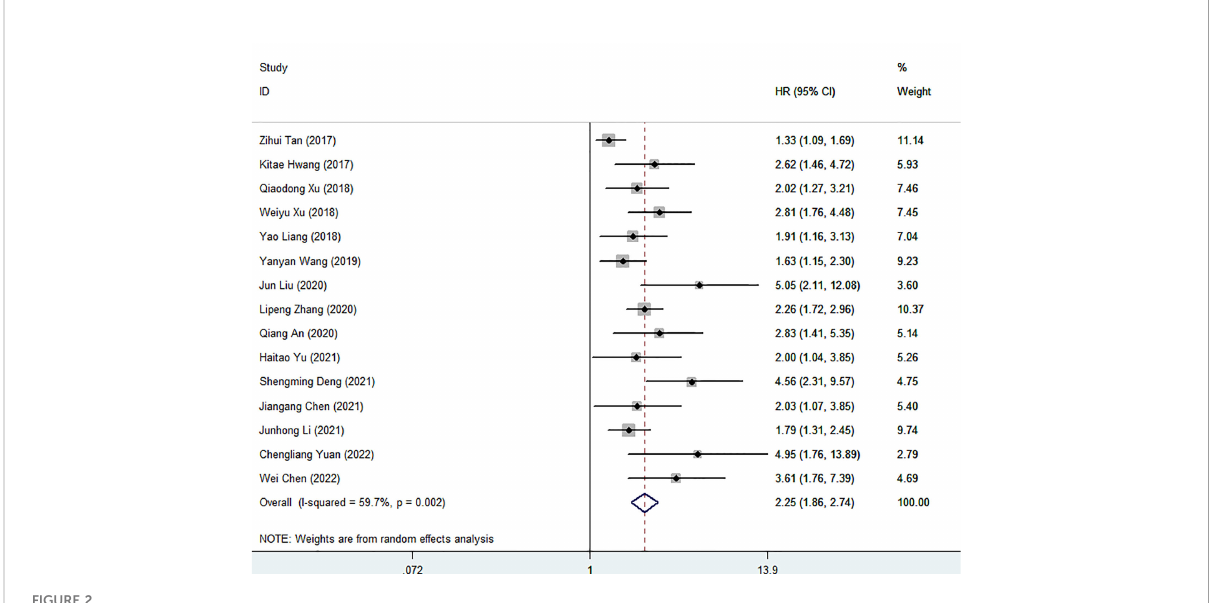
FIGURE 2 Forest plot for the association between FAR and overall survival.